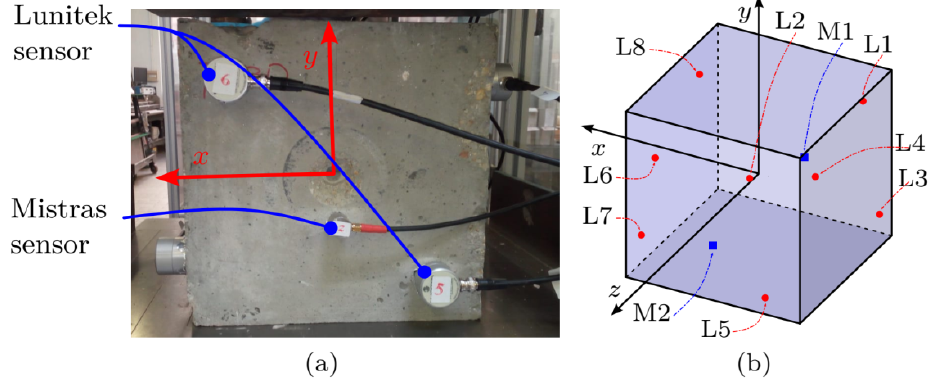
Figure 4. ( a ) Compression test scheme with sample dimensions 0.3 × 0.3 × 0.3 m and, ( b ) AE sensors’ locations. The coordinate system’s origin is at the cube’s geometric center.